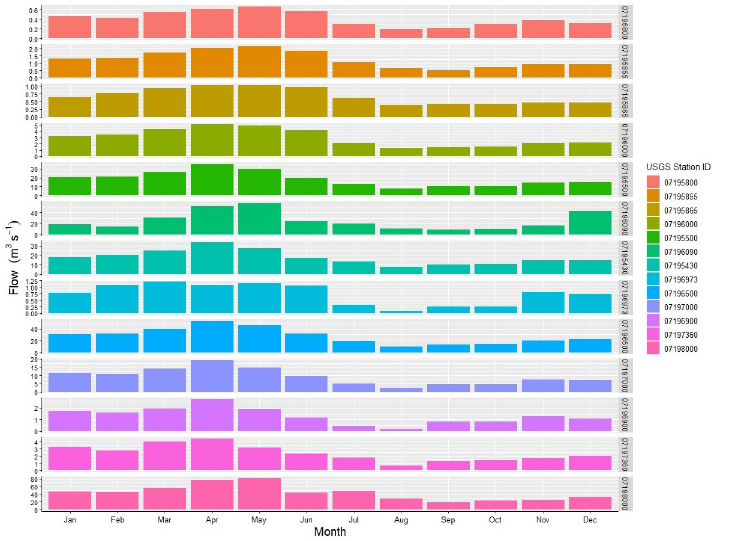
Fig 4. Average monthly streamflow at 13 hydrologic